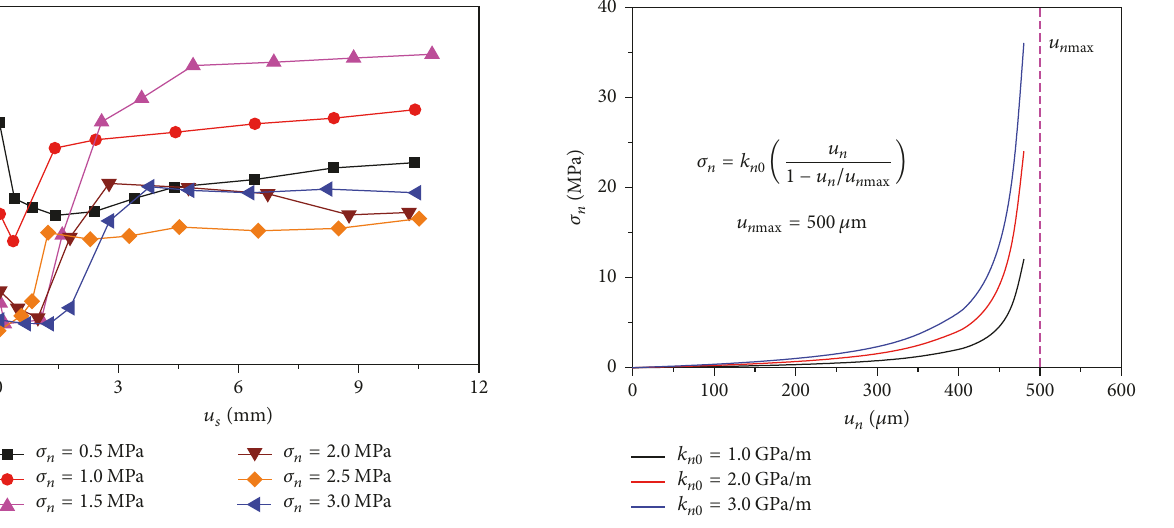
Figure 8: Relationships between 𝜎 𝑛 and 𝑢 𝑛 with different 𝑘 𝑛0